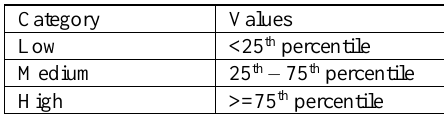
Table 1. Categorization of SMCA score